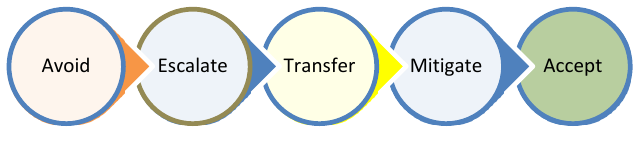
Fig. 3. Five Alternative Strategies for Dealing with Project Risks Fig. 3 Alt Text: Five Alternative Strategies for Dealing with Project Risks: avoid, escalate, transfer, mitigate, and accept (Source, (GUIDE, 2021; PMI 2021